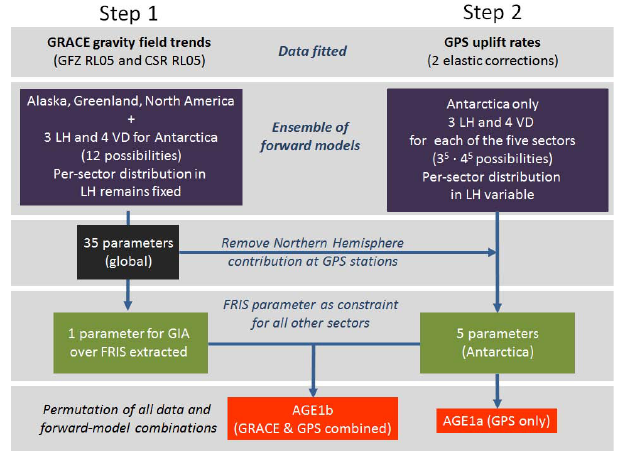
Fig. 2. Scheme of the two-step procedure to derive GIA estimates based on GPS only (AGE1a) as well as GRACE and GPS combined (AGE1b) based on an ensemble of forward